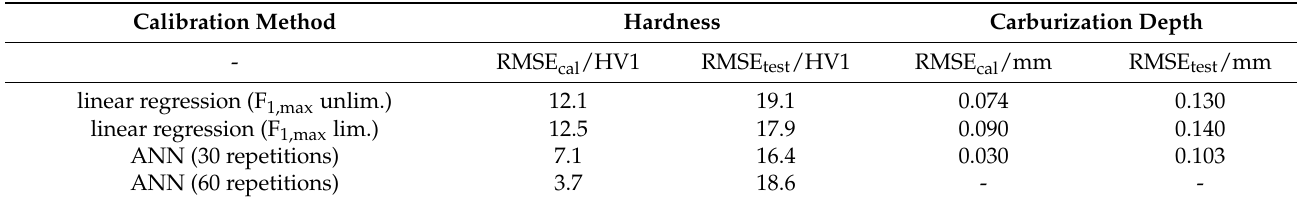
Table 12. Overview of the standard error for the different types of